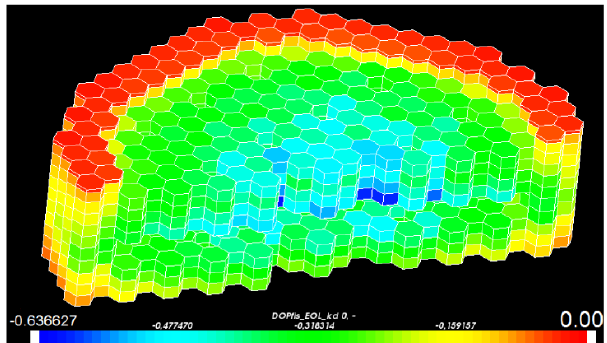
Fig. 12. 3D map of Doppler coef fi cients (pcm) in fi ssile zones.